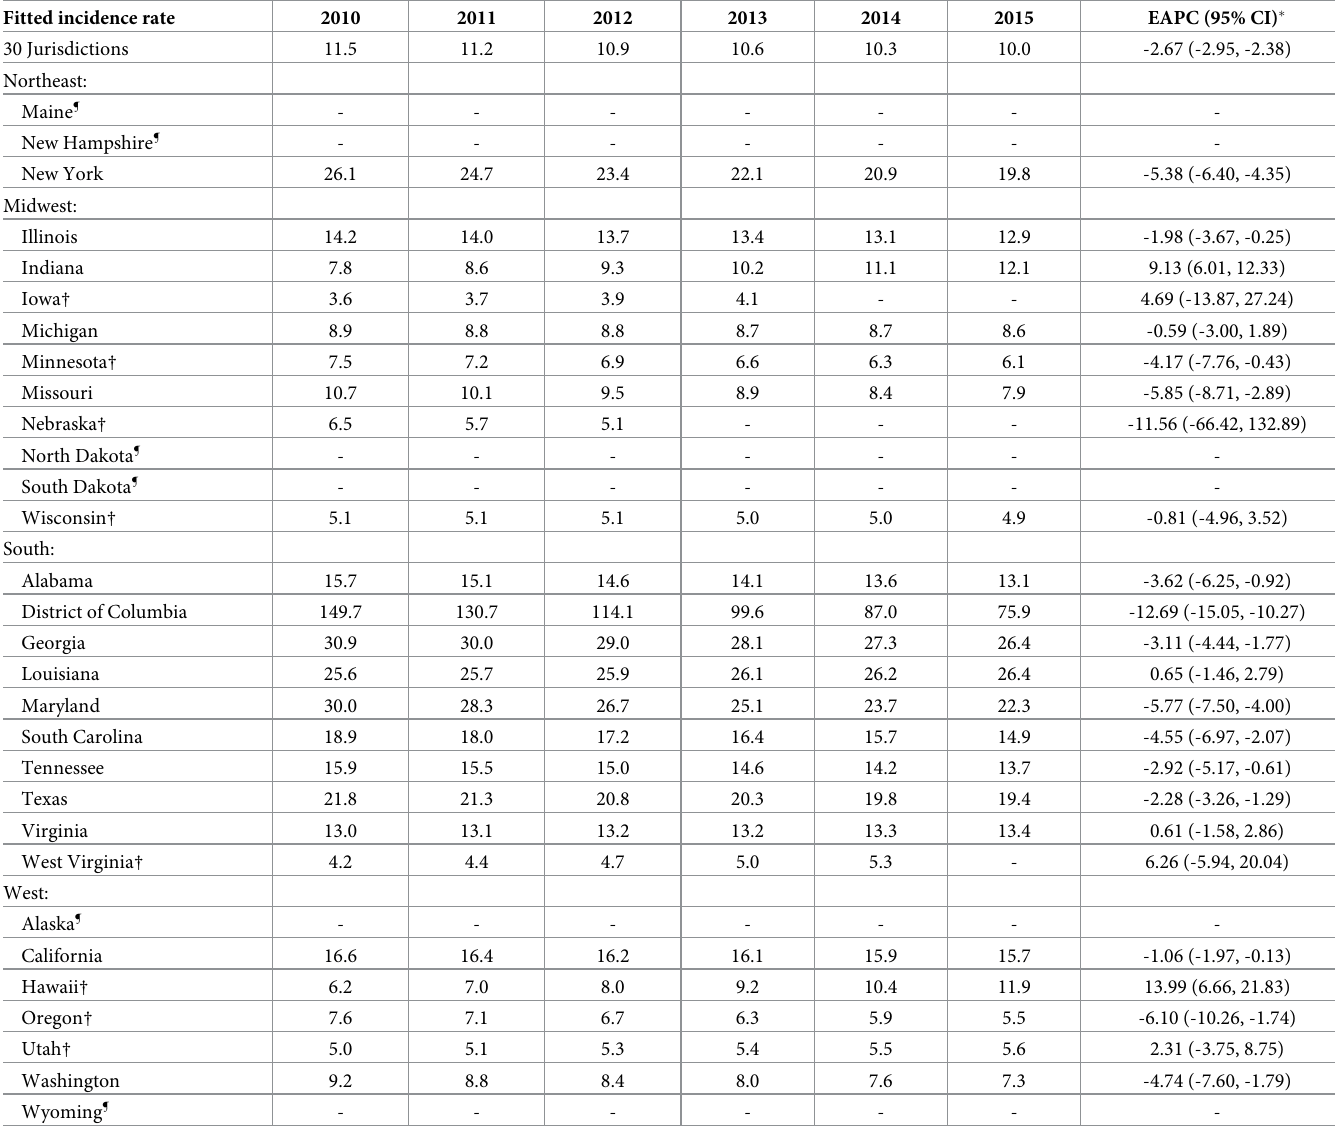
Table 2. Estimated annual percent change (EAPC) in HIV incidence rate by state with corresponding fitted annual incidence rates per 100,000. Fitted incidence